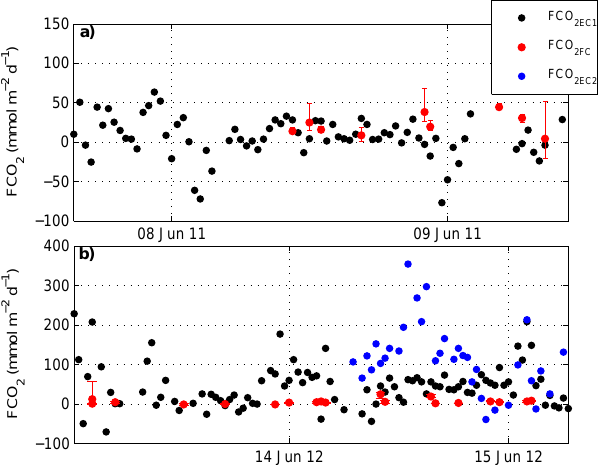
Figure 7. As Fig. 3 but for CO 2 fluxes. Number of direct compar- isons n =